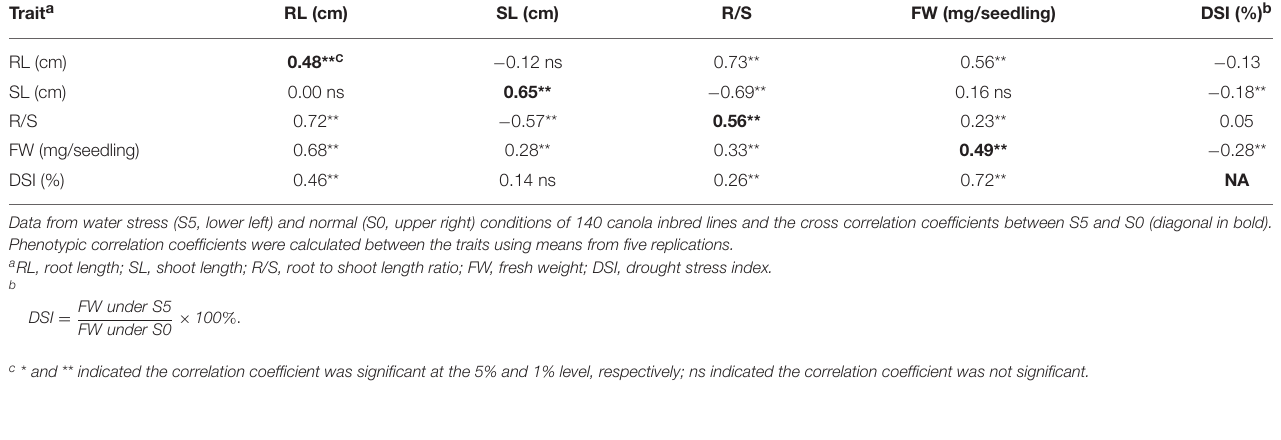
TABLE 2 | Pearson’s phenotypic correlation coefficients between seedling traits measured under normal (S0) and water stress (S5) conditions. Trait a RL (cm) SL (cm) R/S FW (mg/seedling) RL (cm) 0.48 ** c